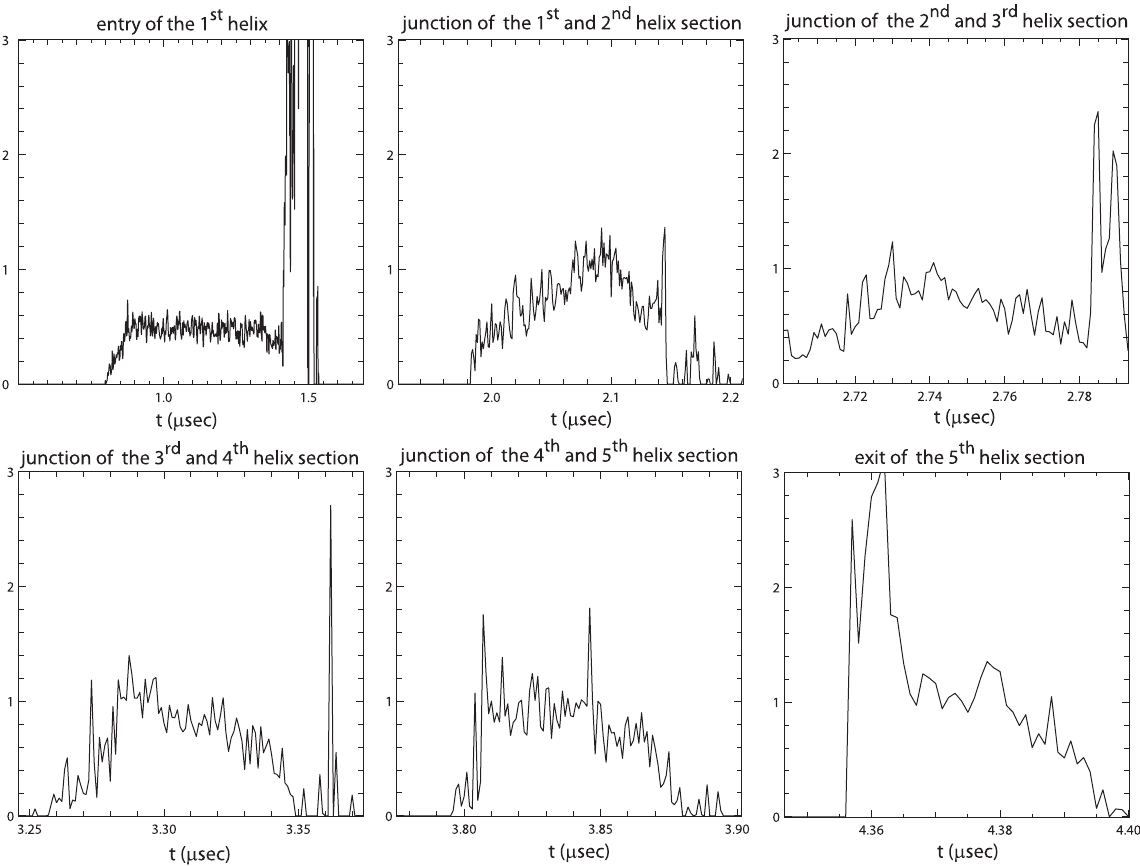
FIG. 13. The normalized emittance " (in (cid:3) mm mrad ) of the ion beam versus time at various positions outside the nx